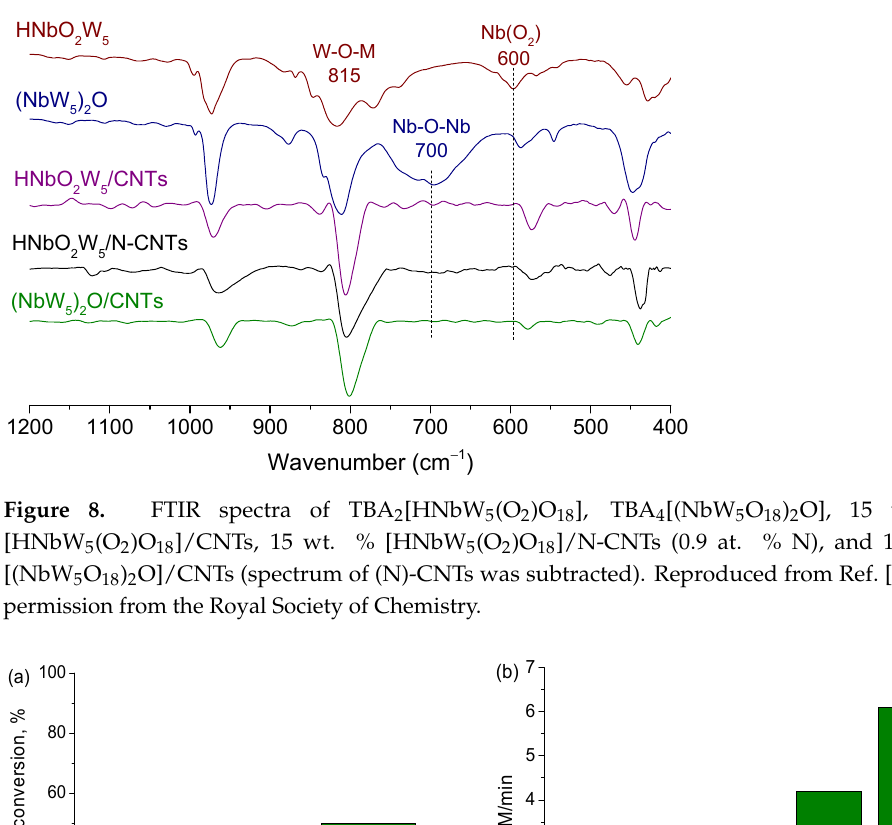
Table 3. Catalytic performance of POM/(N)-CNTs in H 2 O 2 -based oxidation of CyO and CyH in comparison with homogeneous POM (the data taken from refs. [101–103]).